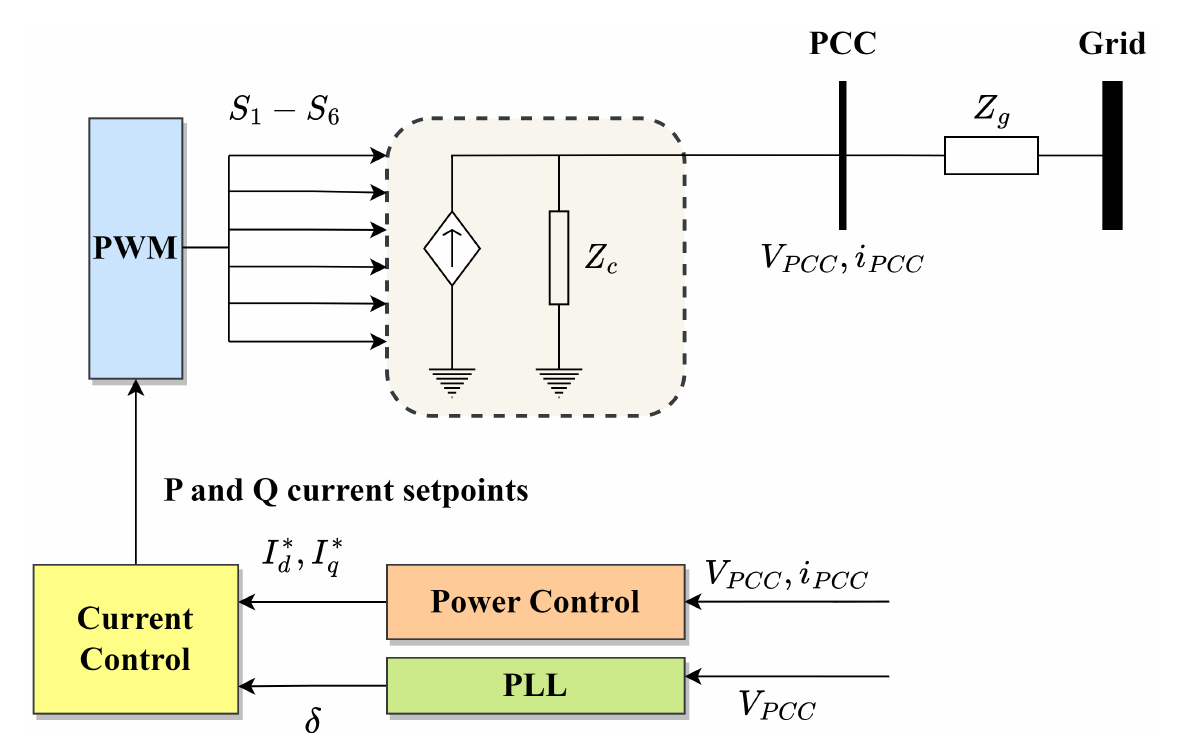
Figure 2. Control approximations of GFL